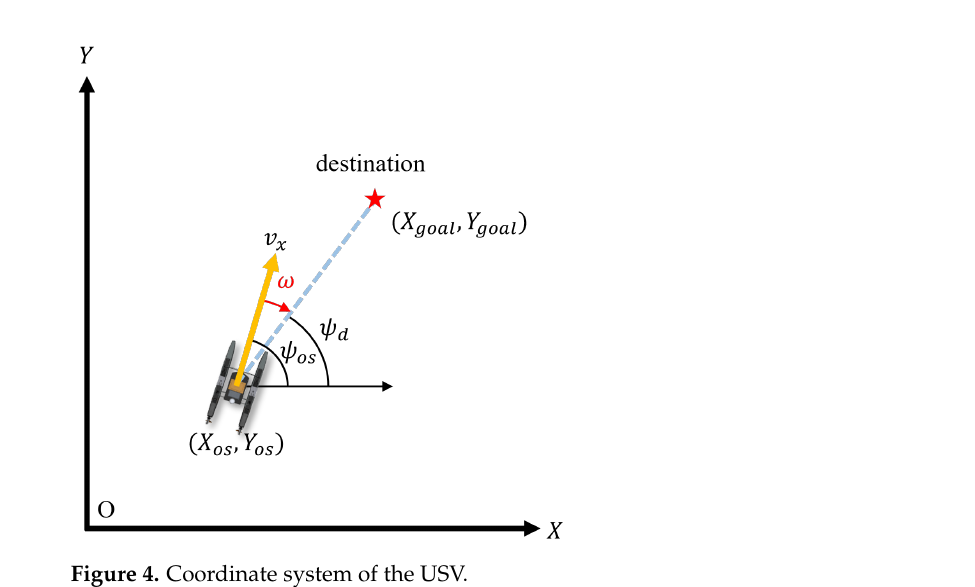
Figure 4. Coordinate system of the USV.